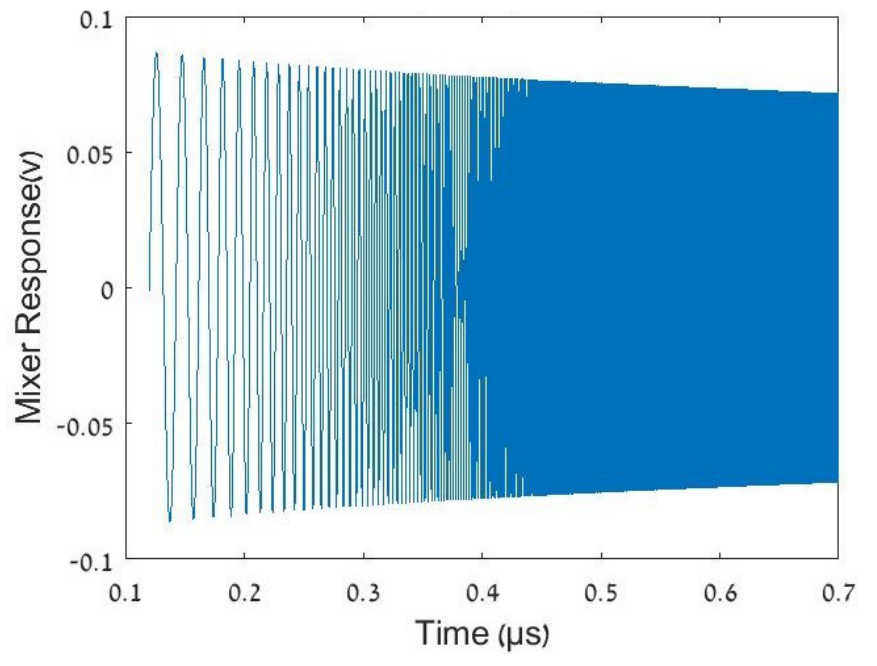
Figure 4. Mixed signal for variable frequency pulse.